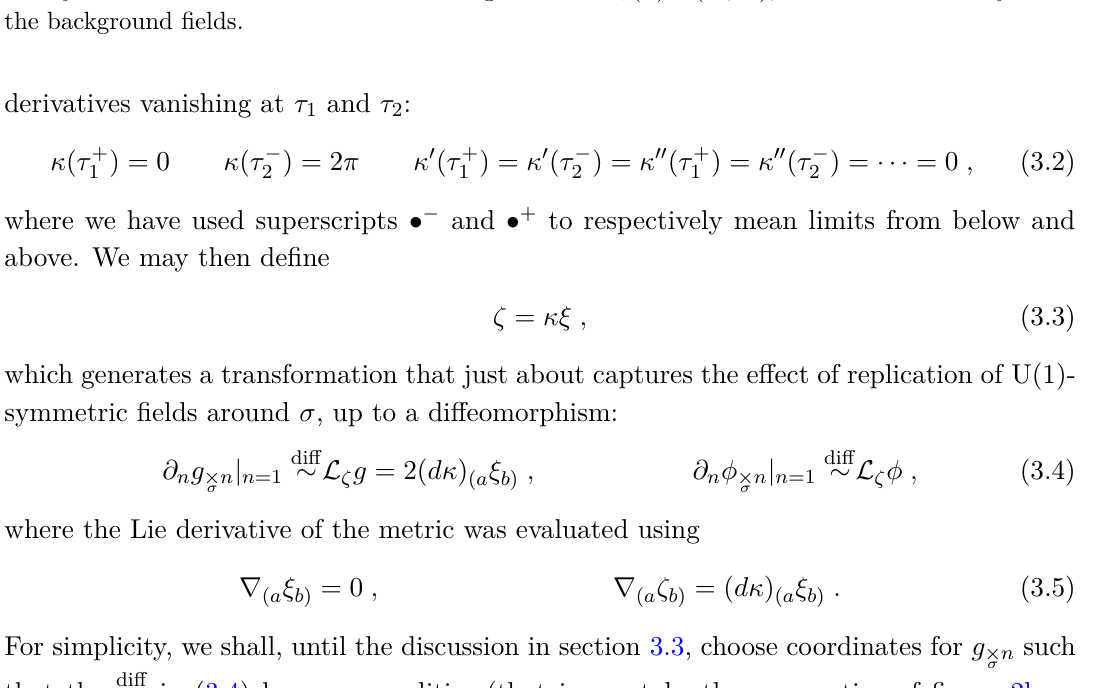
Figure 2. A background ( g, φ ) that is rotation- (i.e. U(1) -) symmetric around a codimension- two surface σ has obvious analytic continuations for the replicated backgrounds ( g × ( g ˜ , φ ˜ ) (with the latter illustrated here) to real n near n = 1 . This is obtained by extending × n × n σ σ the period of thermal time τ to 2 πn , as illustrated in panel 2a. Here, the metric is locally kept fixed (except perhaps in a tiny neighbourhood N a ( σ ) of σ ) but the period of τ has been extended such that the two constant τ surfaces marked by slashes are identified. Alternatively, one can apply a diffeomorphism to the coloured regions such that thermal time τ retains its original period of 2 π , resulting in panel 2b. For n close to 1 , this involves perturbing the background by (( n − 1) L ζ g, ( n − 1) L ζ φ ) within the region marked as S 2 ⊂ ( τ 1 , τ 2 ) — a qualitative sketch of the vector field ζ is shown. Within the infinitesimal region S 1 = N a ( σ ) ∩ ( τ 1 , τ 2 ) , one should smoothly fill in the background